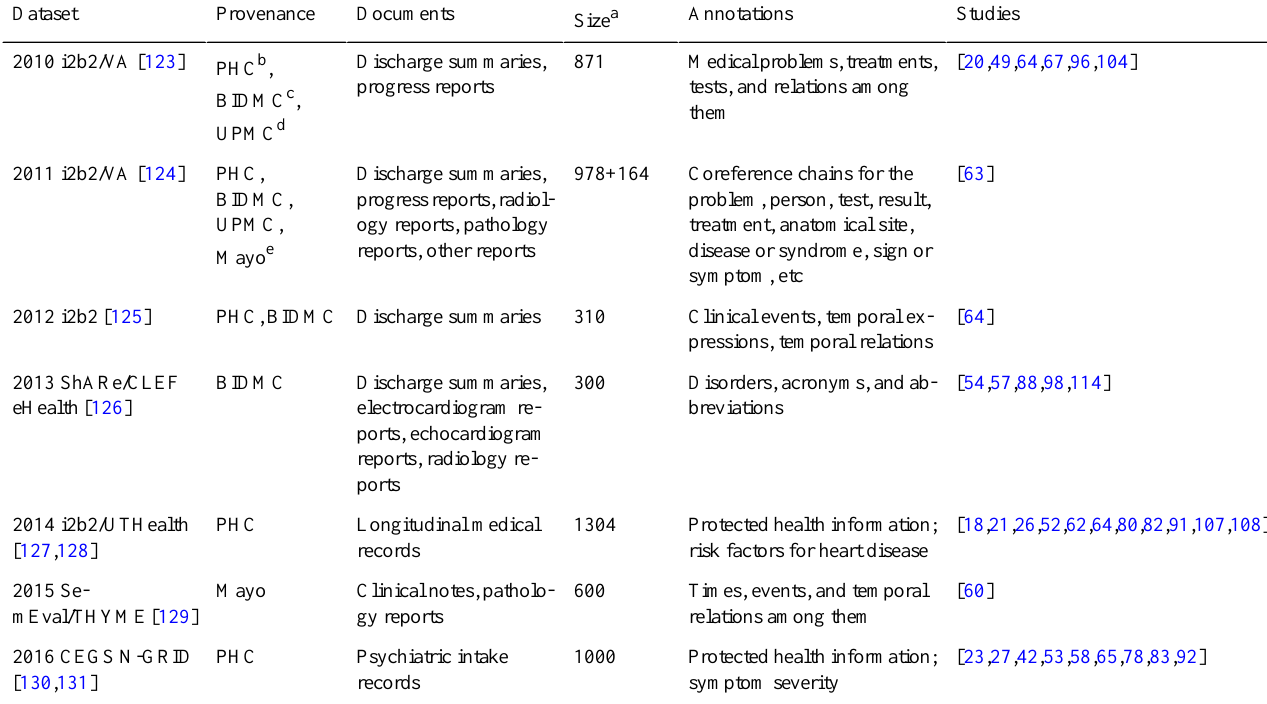
Table 2. Datasets used in clinical natural language processing community challenges.